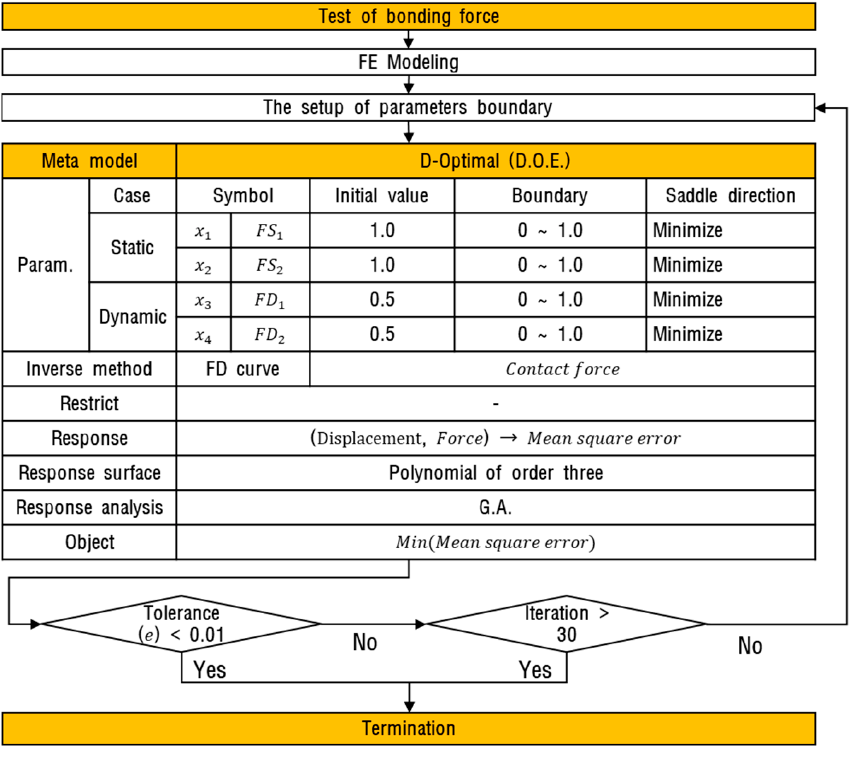
Figure 14. Approximation of grommet bonding force using the inverse method. Table 4. Curve fitting results for Ogden’s incompressible model.